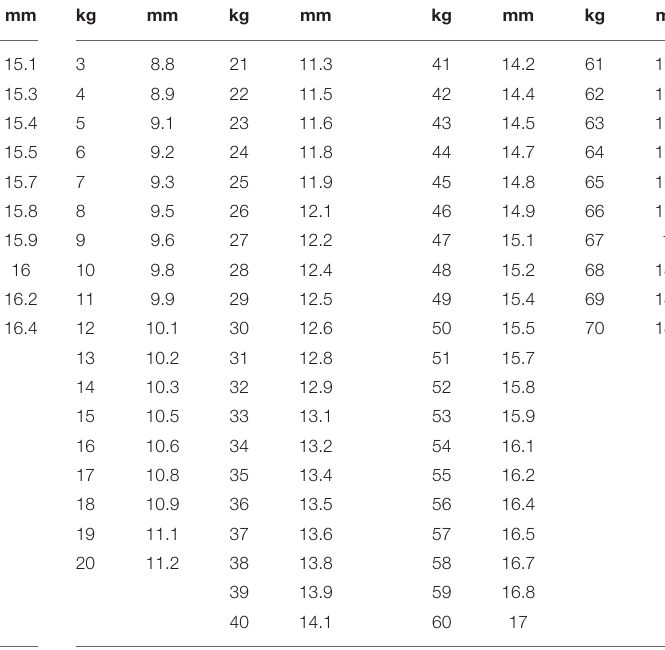
TABLE 2 | Mean diameter of the esophagus as calculated by regression line, lower measuring